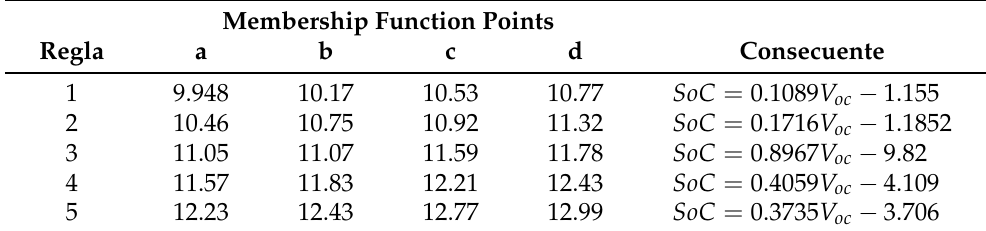
Table 4. Parameters of the membership functions and consequents of the rules used for the model that determines the SoC for a given V oc . The points correspond to trapezoidal membership functions, as shown in Figure 2.